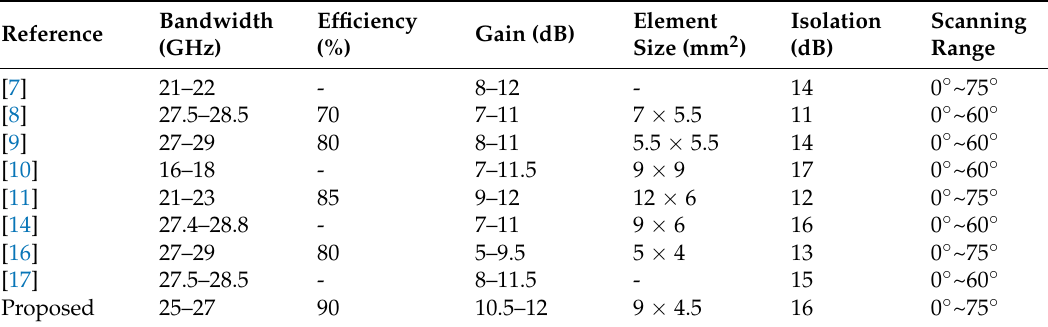
Table 2. Comparison between the proposed and the reported mobile handset antennas.